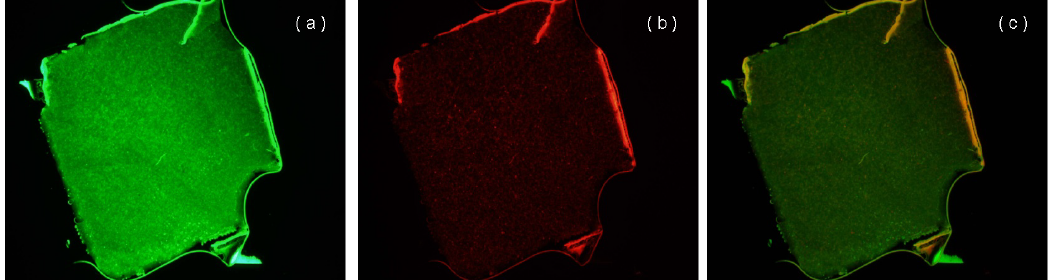
Figure 10. Viability of microorganism in pellets ( a ) for living cell only ( b ) for dead cell only ( c ) for living cell + dead cell.